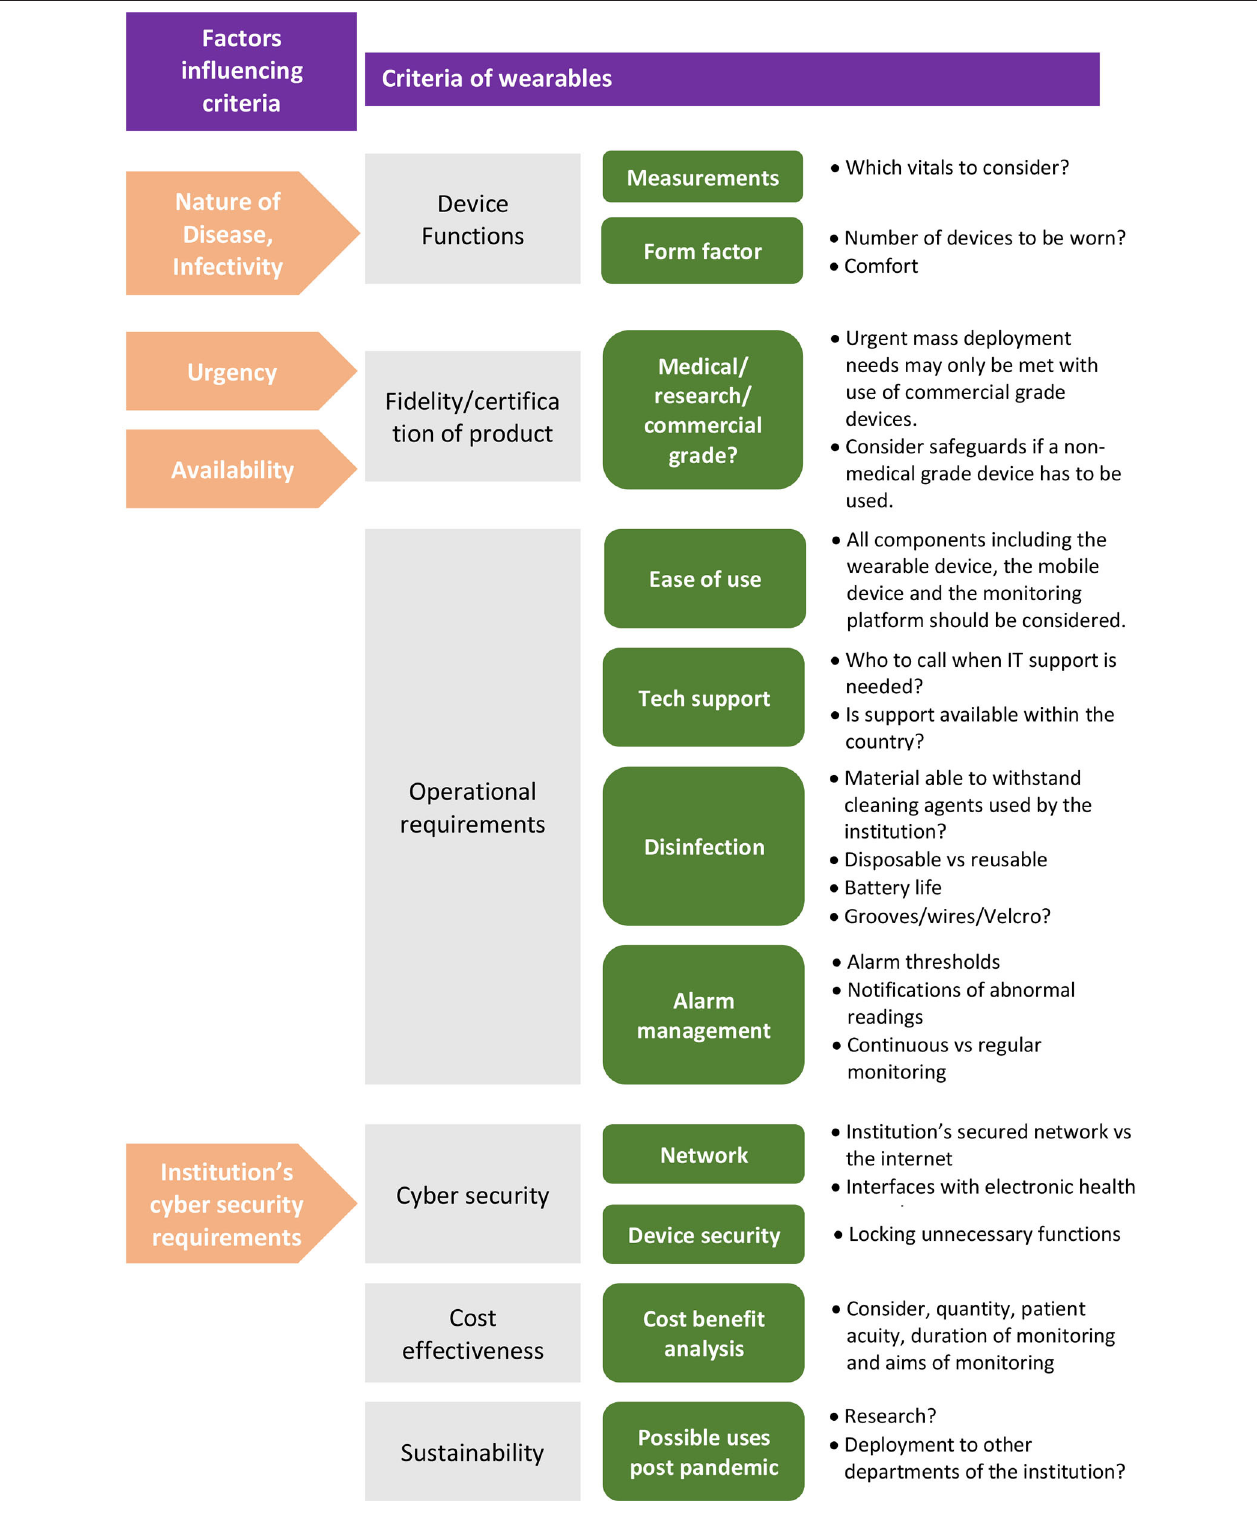
FIGURE 2 | Overview of criteria to determine suitability of a wearable vital signs monitoring solution.